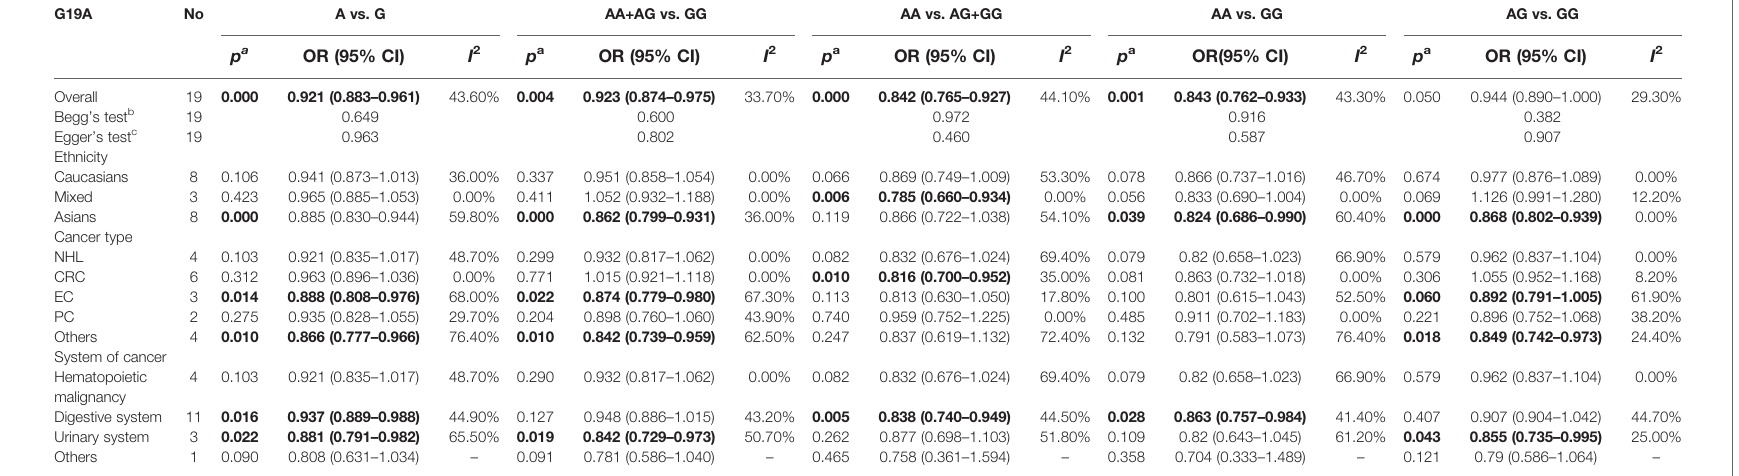
TABLE 3 | The association between LEP G19A and cancer